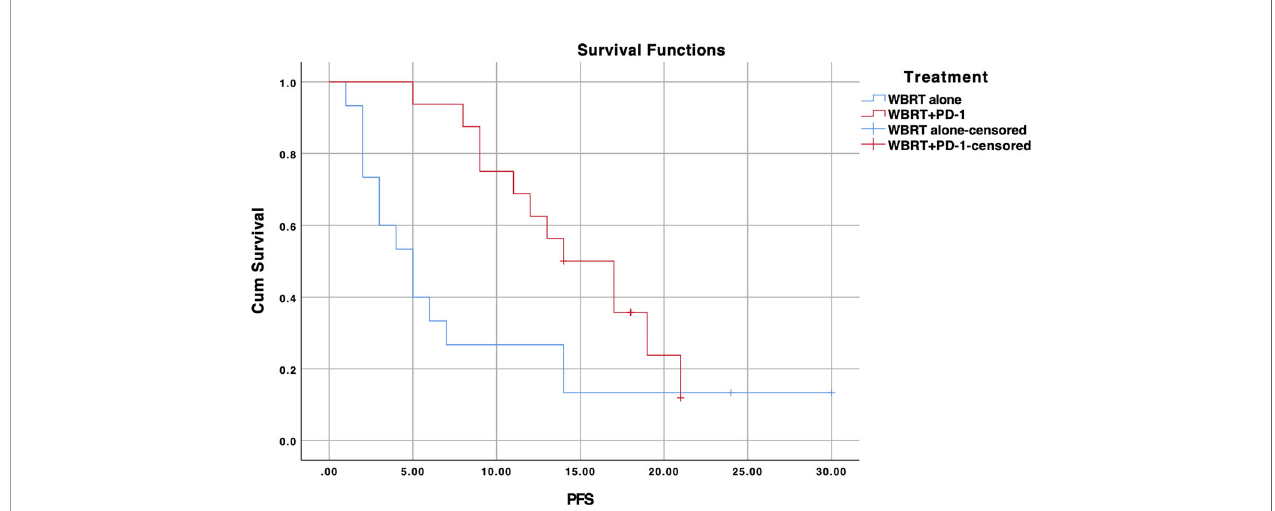
FIGURE 3 | Kaplan-Meier progression-free survival (PFS) curve for treatments; WBRT alone (No PD-1), and WBRT plus PD-1 inhibition therapy (WBRT+PD-1). Cum, cumulative.